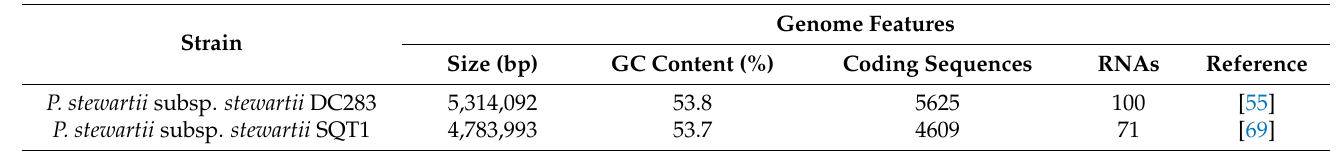
Table 3. Genome features of the complete genome sequence of P. stewartii subsp. stewartii DC283 and draft genome sequence of P. stewartii subsp. stewartii